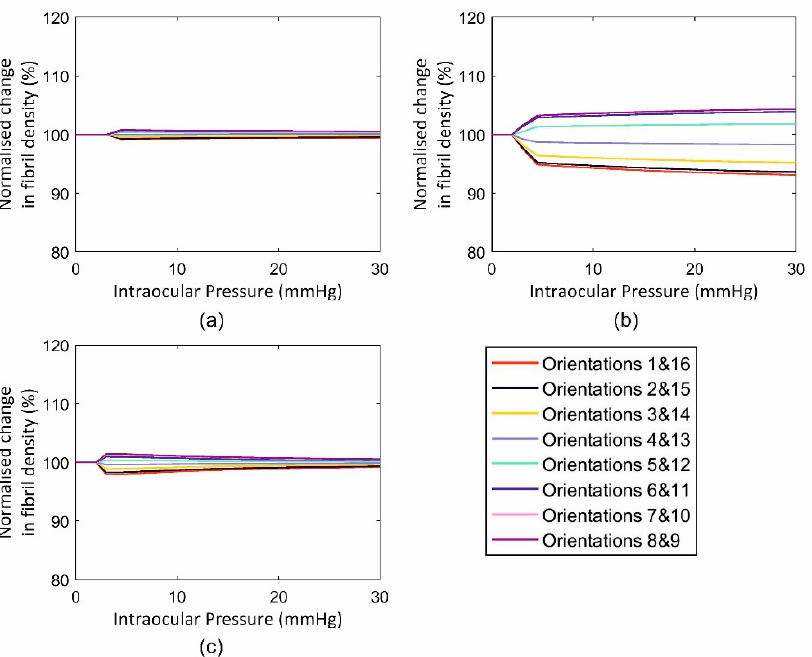
Figure 10. Fibril reorientation in the intact inflated ocular model under intraocular pressure up to 30 mmHg at three locations across the cornea including ( a ) element 1, ( b ) element 2 and ( c ) element 3.